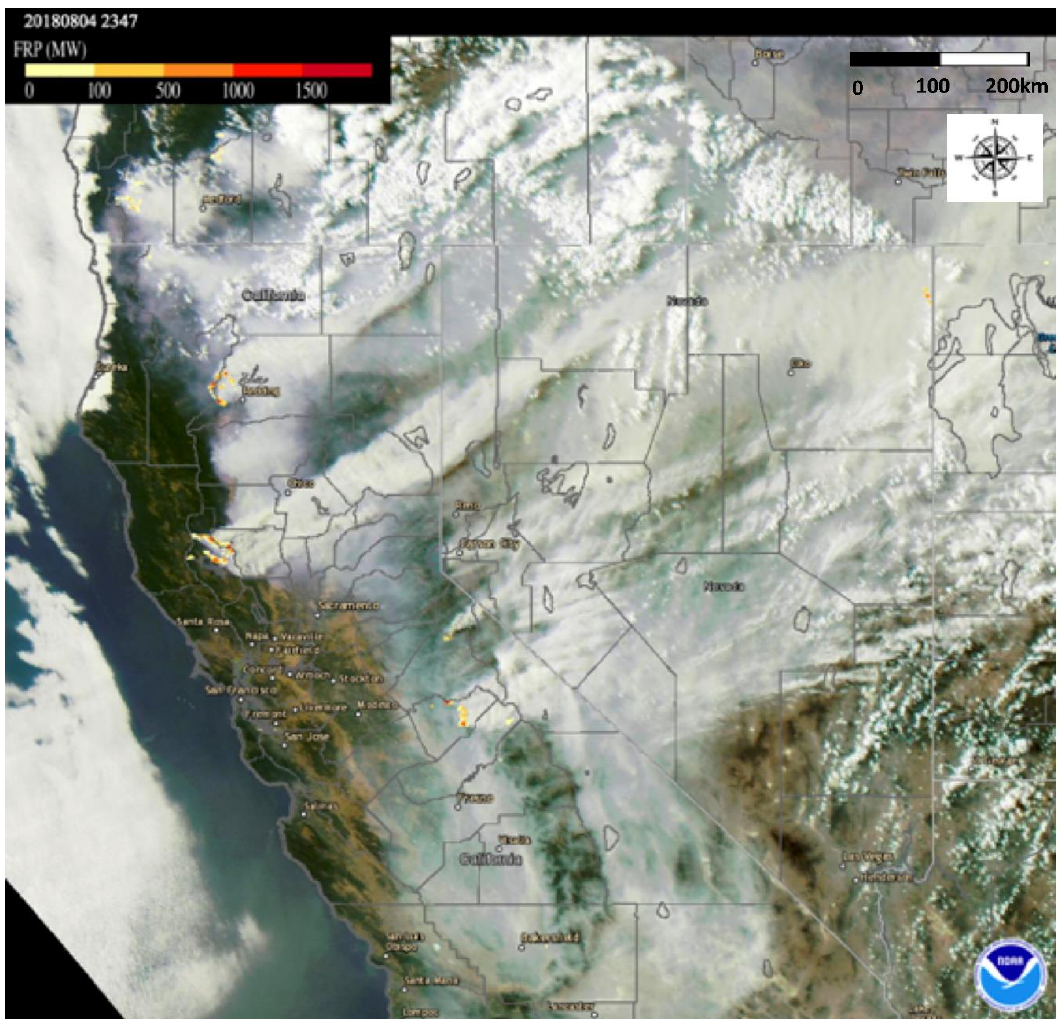
Figure 1. Visible smoke plume from the GOES-16 satellite at 2347 UTC and fire radiative power from the VIIRS instrument aboard Suomi-NPP on August 4 2018. Image from NOAA AerosolWatch.